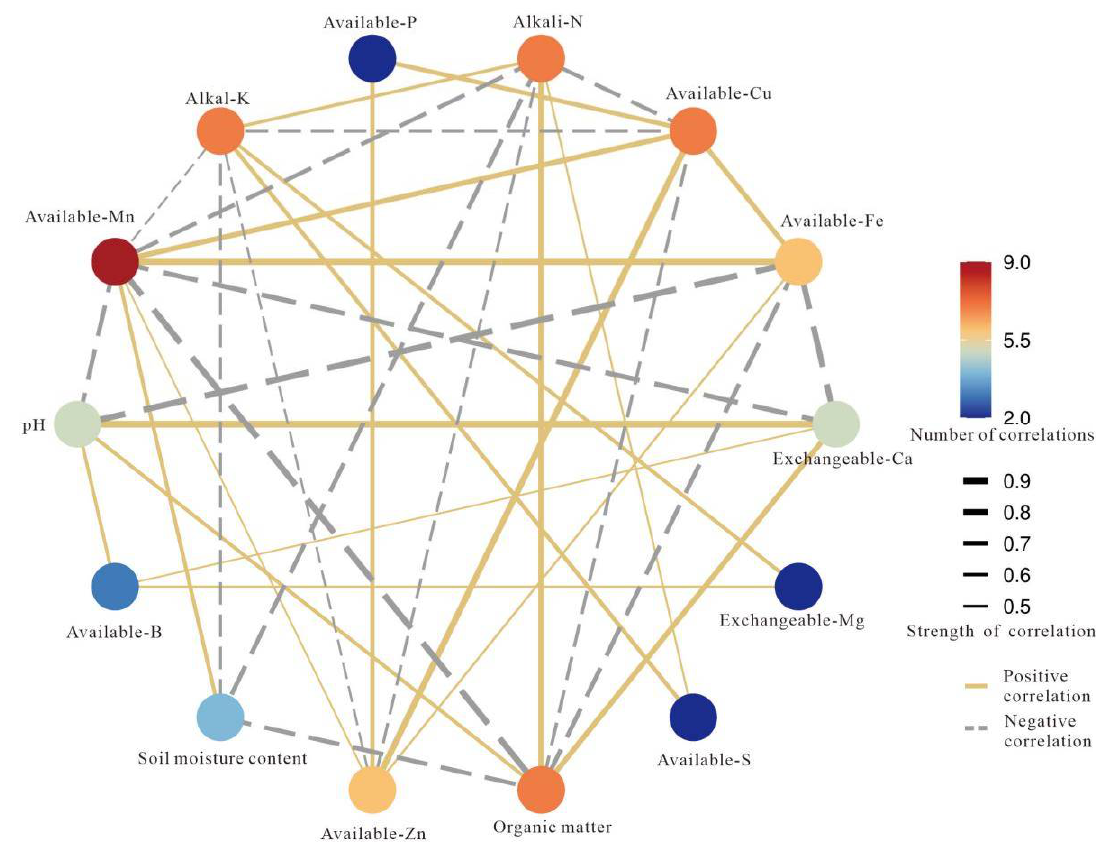
Figure 3. The correlation network of the soil effective state in the Tainong mango orchards.